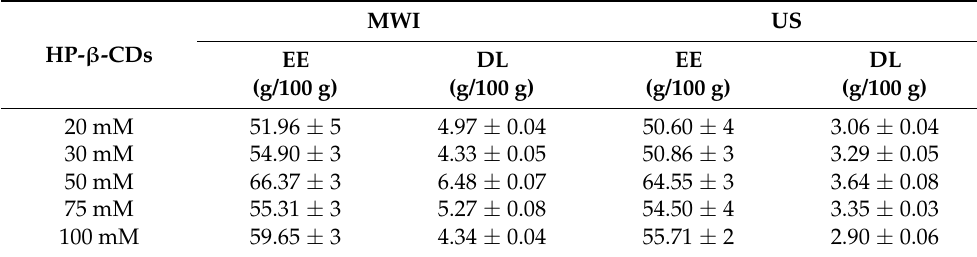
Table 2. Encapsulation efficiency (EE) and drug-loading (DL).